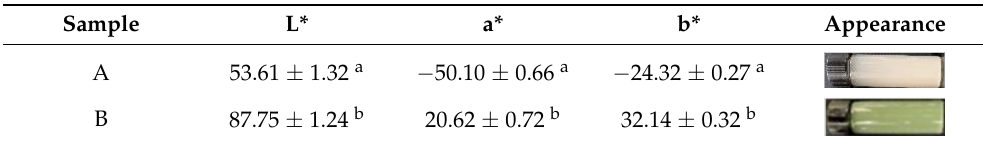
Table 3. The effect of reFAE2 on the color parameters and photographs of SSPs (A: Without enzyme- treated solution of SSP; B: Enzyme-treated solution of SSP). Sample L* a* b* Appearance A 53.61 ± 1.32 a − 50.10 ± 0.66 a − 24.32 ± 0.27 a B 87.75 ± 1.24 b 20.62 ± 0.72 b 32.14 ± 0.32 b Different letters (a, b) in the same column indicate significant differences at p <